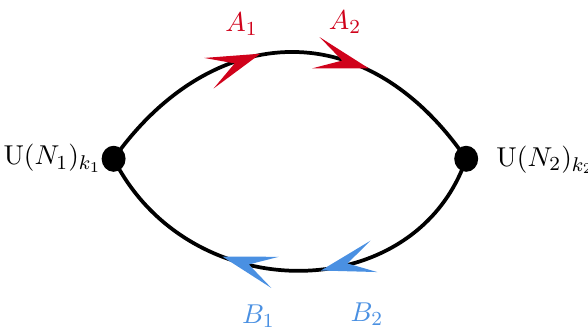
Figure 1 . The N = 3 GT quiver diagram. A 1 and A 2 are bifundamental hypermultiplets and B 1 and B 2 are anti-bifundamental hypermultiplets coupling the nodes of the